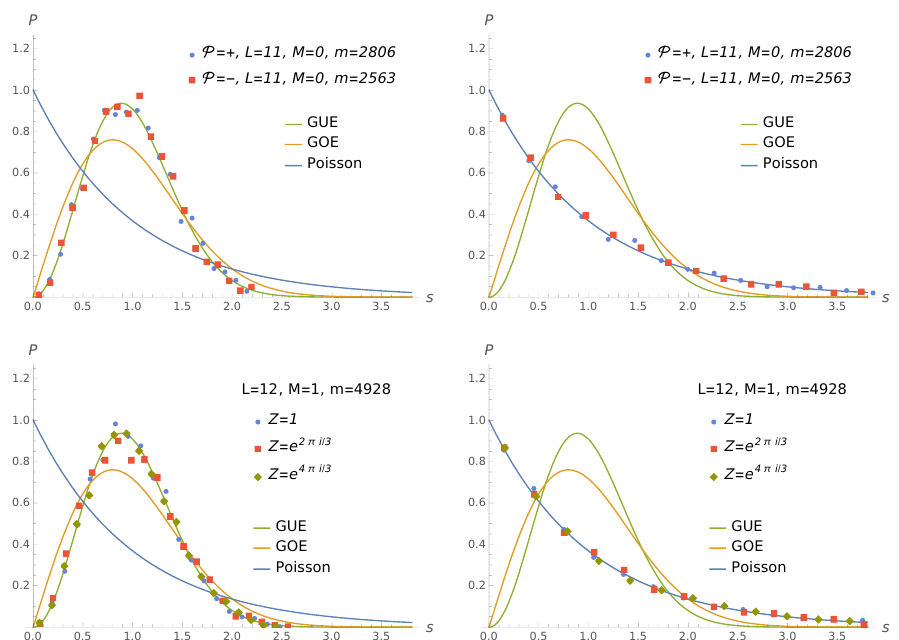
Figure 4 . Left: distribution of level spacings for (top) L = 11 , M = 0 with positive and negative parity and (bottom) L = 12 , M = 1 in all three sectors with generic values of the parameters resulting in a chaotic spectrum. Right: distribution of level spacings with integrable values of the parameters for (top) L = 11 , M = 0 both parities and (bottom) L = 12 , M = 1 . cyclic symmetry transforming the flavours at each site as in (3.6), this cannot be